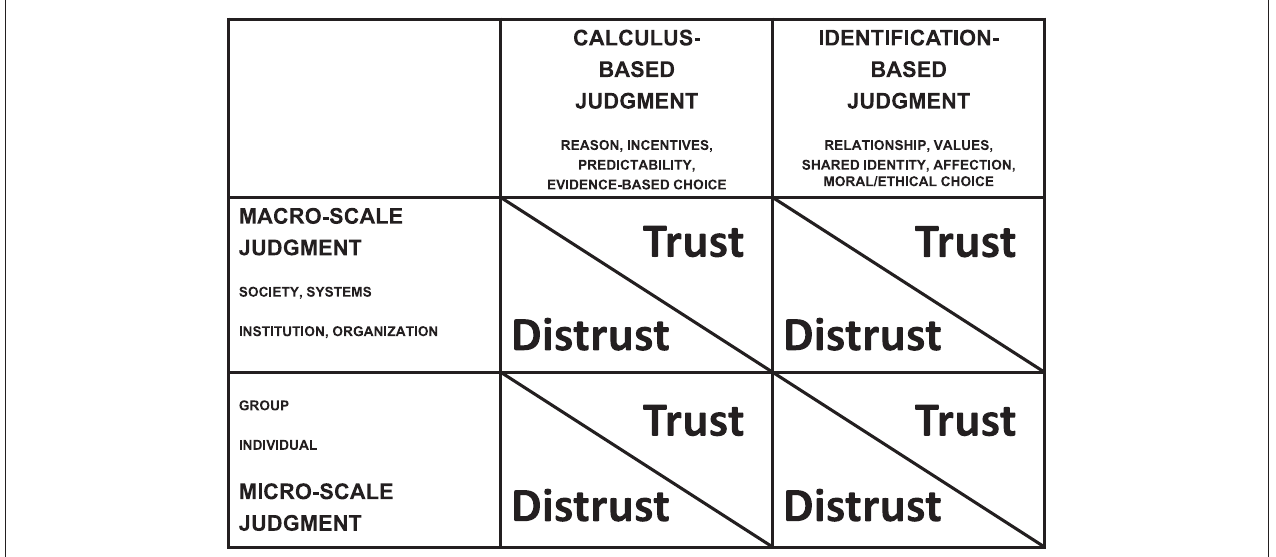
FIGURE 1 | The Trust/Distrust Matrix